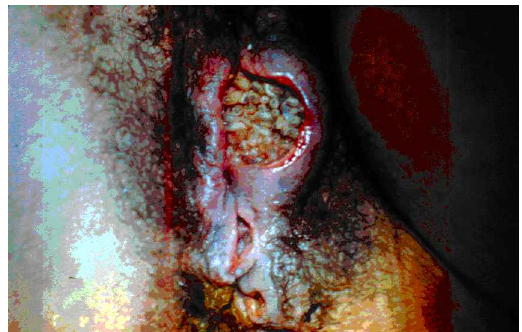
Figure 1 Case 1; large cavitary lesion containing more than 100 maggots